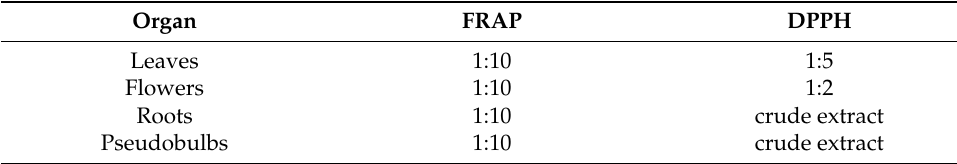
Table 4. Extract dilutions tested in FRAP and DPPH